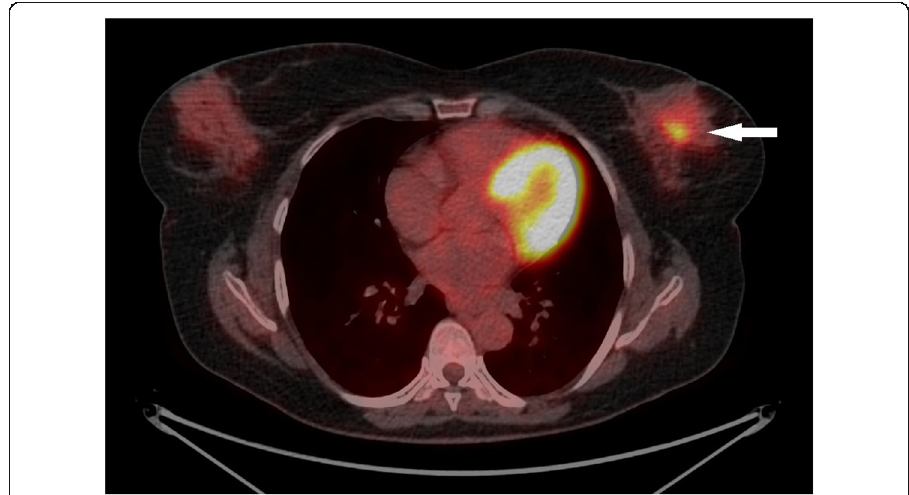
Fig. 1 Transverse image of 18 F-FDG PET/CT in patient with breast cancer. Representative transverse image in patient with HR negative IDC, with high score of HER2 expression and Ki 67 of 30%. PET/CT shows primary tumor of the left breast (SUVmax=7.4). Classification after PET/CT was T1cN0M0. With the permission of